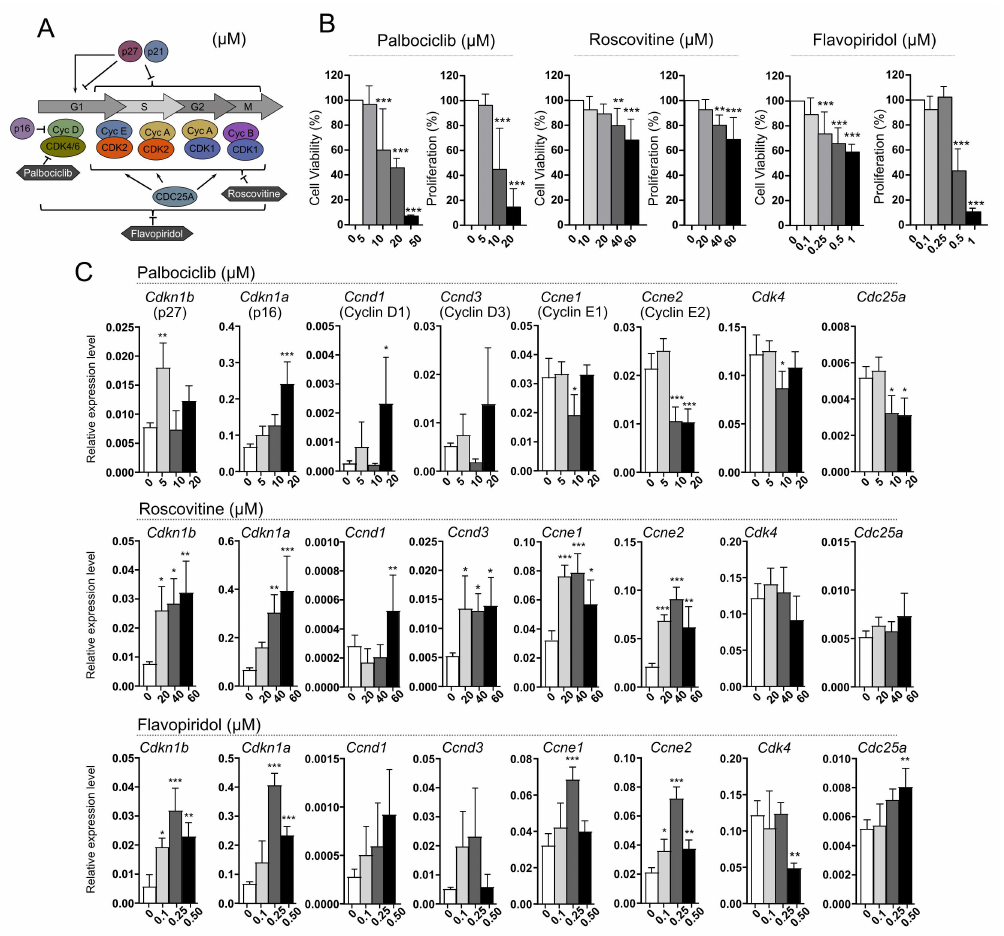
Figure 3. The effect of inhibitors of cyclin-dependent kinases (CDKs), palbociclib, roscovitine and flavopiridol, on AtT-20/D16v-F2 corticotroph cells. ( A ). Simplified scheme of cell cycle regulation indicating the specificity of each CDK inhibitor; ( B ). The effect of cell cycle inhibitors on viability and proliferation of AtT-20/D16v-F2 cells. Difference in viability and proliferation of treated cells was evaluated in comparison to untreated cells. ** indicates p < 0.001, *** indicates p < 0.0001; ( C ). The expression of genes encoding key cell cycle regulators in AtT-20/D16v-F2 cells treated with palbociclib, roscovitine and flavopiridol. Difference in the gene expression level in treated cells was evaluated in comparison to untreated cells. * indicates p < 0.05, ** indicates p < 0.001, *** indicates p <